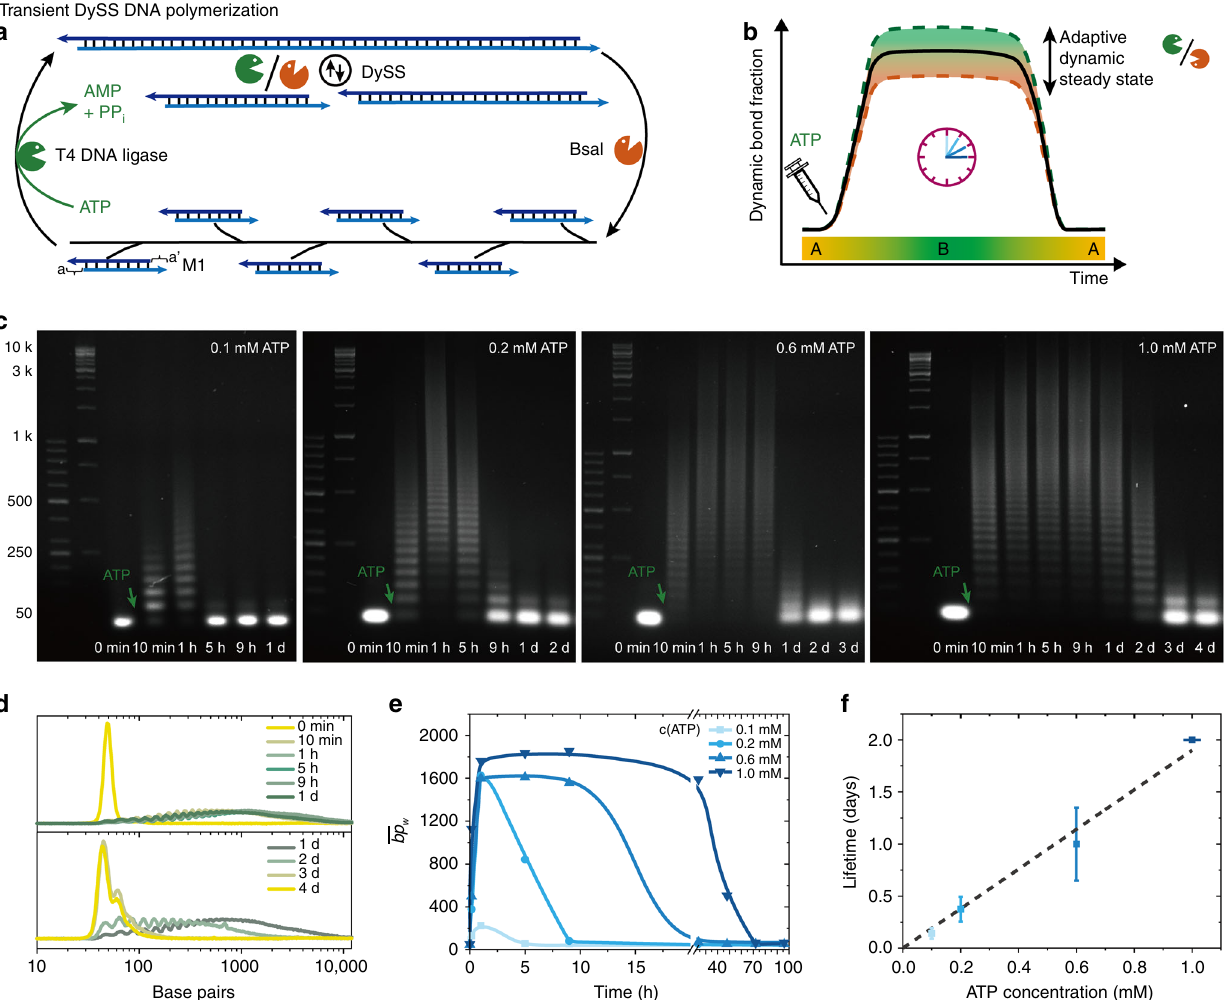
Fig. 2 ATP-fueled transient DySS DNA polymerization. a , b General scheme for ATP-powered transient DySS polymerization and control over lifetimes and adaptive DySS properties. The system enters into a DySS, state B, from its monomer state, state A, upon fueling with ATP, and returns to state A once the ATP is consumed. c Time-dependent AGE (2 wt. %, 90 V, 2 h) for transient DNA polymerizations with programmable lifetimes by fueling with varied ATP concentrations (0.1, 0.2, 0.6, and 1.0 mM). d Gray scale pro fi les from AGE at 1.0 mM ATP quantifying the transient shift of molecular weight, which is used to calculate the mass-weighted average chain length ( bp w ) for each kinetic aliquot. e The bp w development with time by varying the ATP concentration from 0.1 to 1.0 mM. Lines are guides to the eye. Multiple ATP injections are shown in Fig. 3. f Lifetimes are controlled by the ATP concentration. Error bars are standard deviations of duplicate measurements. Conditions: 37 °C, 0.05 mM M1, 0.46 WU μ L − 1 T4 DNA ligase, 2.5 U μ L − 1 BsaI, and varying amounts of